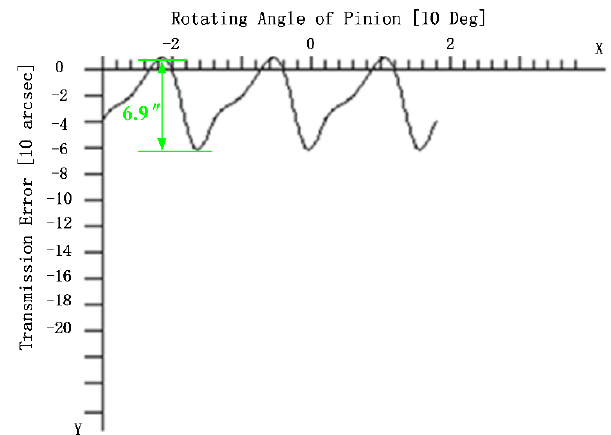
Figure 13. LTE of the gear pair calculated by the simulation method.